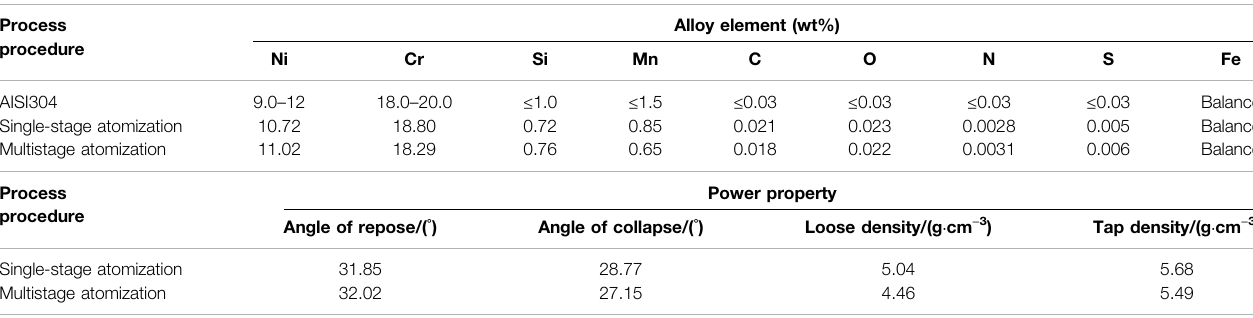
Alloy element (wt%)